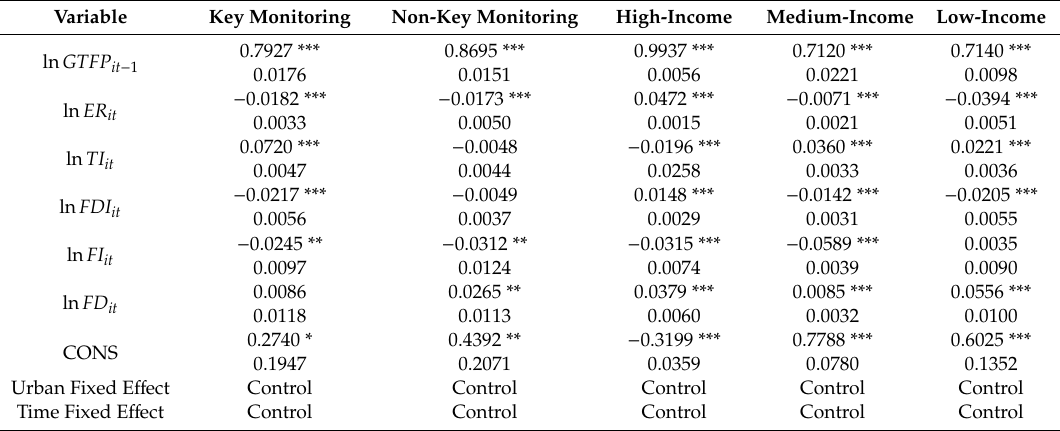
Table A1. Regression results of cities at di ff erent monitoring levels and development